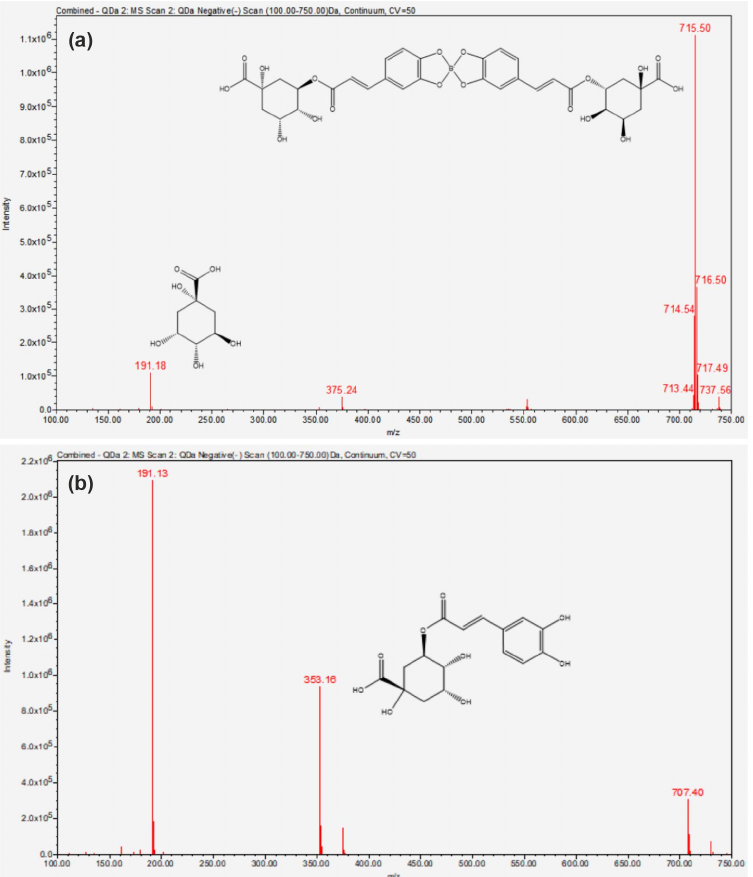
Figure 3. Mass spectrometry analysis: ( a ) Mass spectrum of 5-DCB semisynthetic standard (frag- ment ion m / z 715) with quinic acid fragment ion ( m / z 191); ( b ) mass spectrum of 5-CQA (fragment ion m / z 353). 5-CQA: 5-Caffeoylquinic acid; 5-DCB: Diester chlorogenoborate.